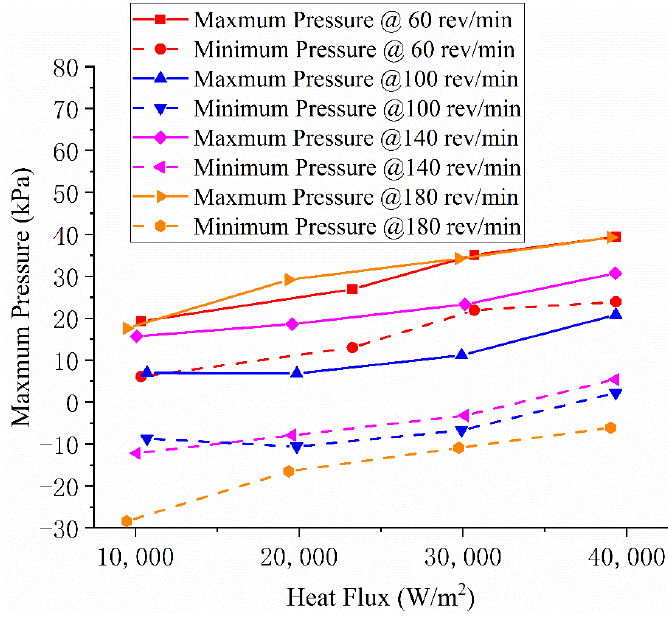
Figure 11. Change of pressure extremums with revolving speed and heat flux.